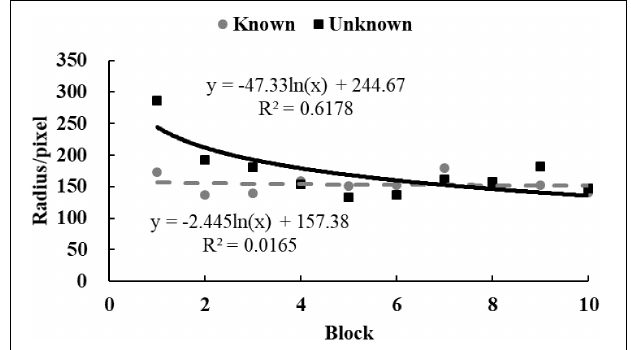
FIGURE 4 | The M of radii size in Study 2. The solid and dotted lines represent the regression curves for the unknown and known conditions, respectively.